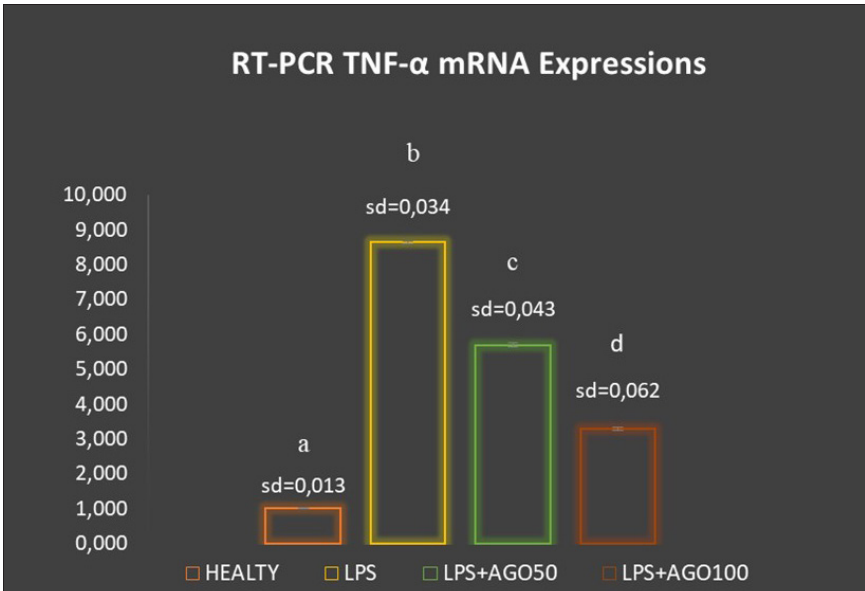
Figure 2. The effects of agomelatine on TNF- α mRNA expressions of lung tissue. Gene expression was detected by quantitative RT-PCR analysis. The results were normalized to b-actin (housekeeping gene control). The relative expression levels were calculated by the 2-ΔΔcT method and were indicated as “fold change” compared with control groups. Means that have the same letter are not significantly different to those of the test of Duncan ( P = .05). LPS: lipopolysaccharide, AGO: agomelatine, SD: standard deviation, RT-PCR: real-time polymerase chain reaction,